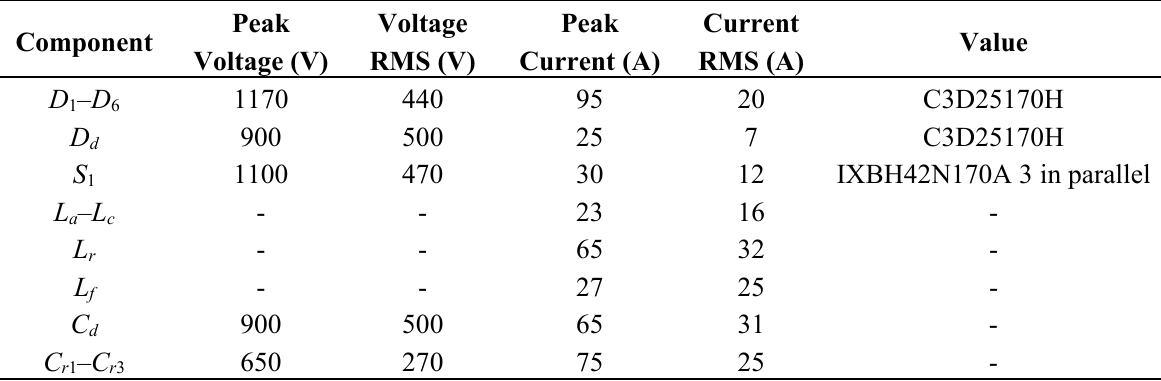
Table 3. Voltage and current stress of the main power